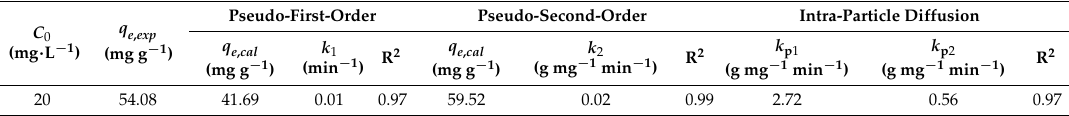
Figure 5. ( a ) Effect of contact time on the adsorption capacity of La-chitosan magnetic spheres, ( b ) pseudo-first-order model, ( c ) pseudo-second-order model, and ( d ) intra-particle diffusion model. Table 1. Adsorption kinetic parameters of phosphorus onto La-chitosan magnetic spheres.